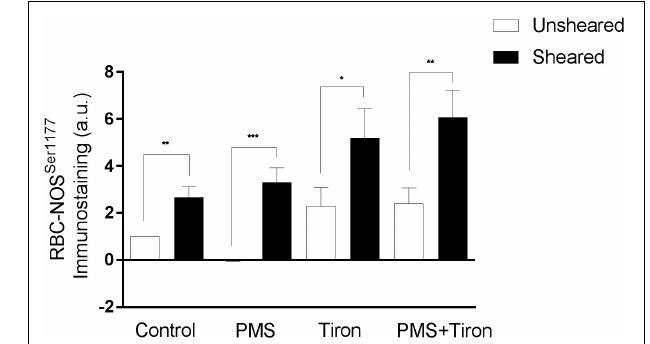
FIGURE 4 | Cellular deformability (expressed as SS 1 / 2 :EI max ) of RBC exposed to phenazine methosulphate, a superoxide scavenger (Tiron), or combined PMS and Tiron (PMS + Tiron). Data collected for cells following 60 min “rest” (unsheared) or following 5 min of shear conditioning (sheared; see text for details). Significantly different between designated pairing at ∗∗∗ p < 0.001, ∗∗ p < 0.01, or ∗ p < 0.05.